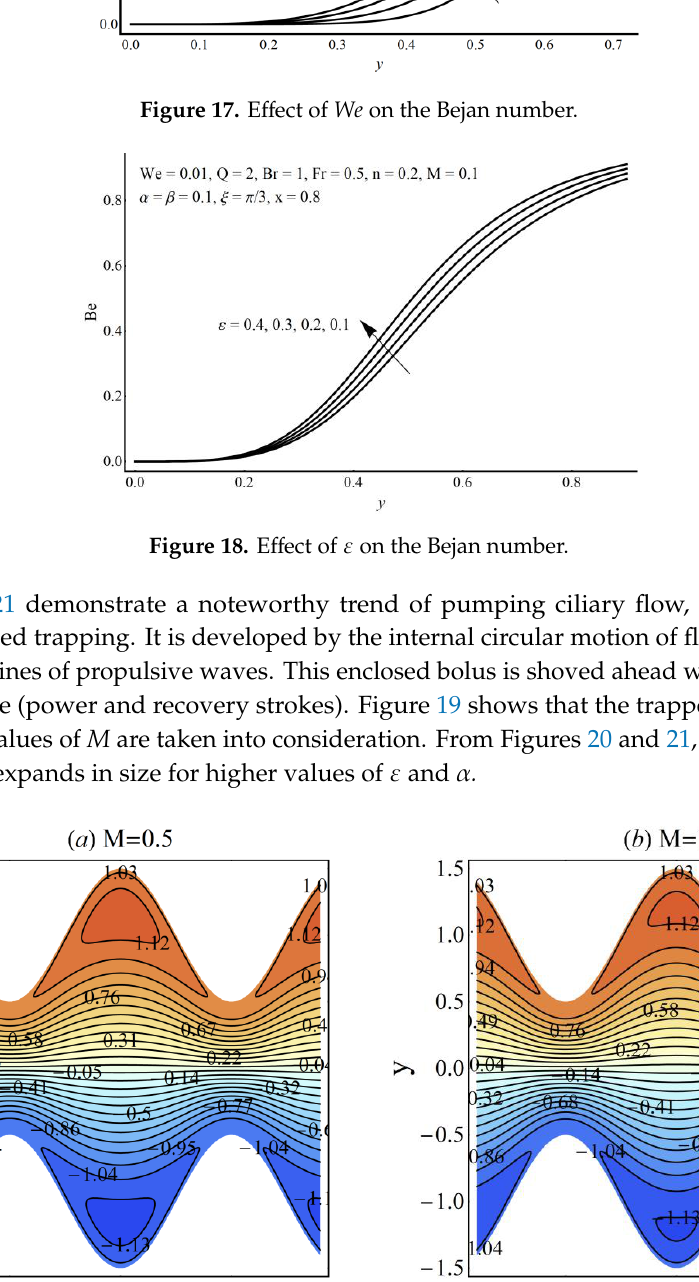
Figure 20. Streamlines at different ε when Fr = 1, n = 0.2, α = 0.1, We 2 = 0.01, β = 0.5, ξ = π/3, Fr = M = 0.5: (a) ε = 0.4 and (b) ε = 0.5.